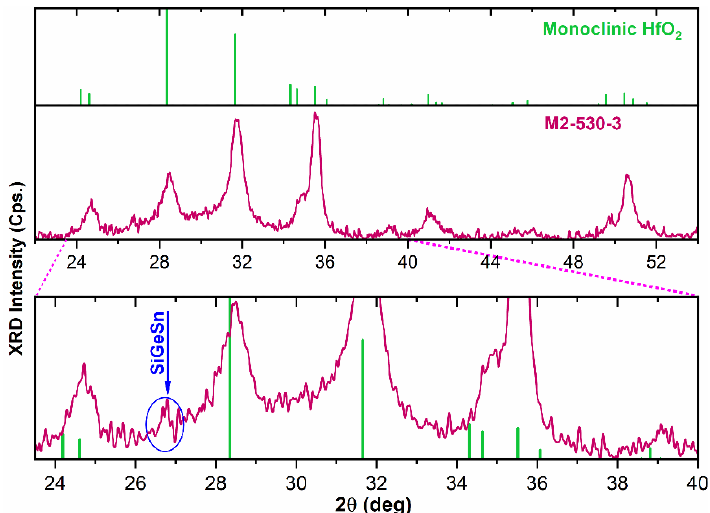
Figure 2. XRD diffractogram of structure M2-530-3: high-intensity peaks correspond to monoclinic nanocrystallized HfO 2 by comparing with PDF 01-078-0049 data (indicated in green on top of figure). A small intensity feature around 26.8 deg seen as a shoulder of (–111) HfO 2 maximum can be observed. This feature related to (111) diamond maximum suggests the formation of SiGeSn NCs, and is evidenced (and indicated by an arrow and encircled) in the 23.5–40 deg zoom of XRD curve from the bottom part of the